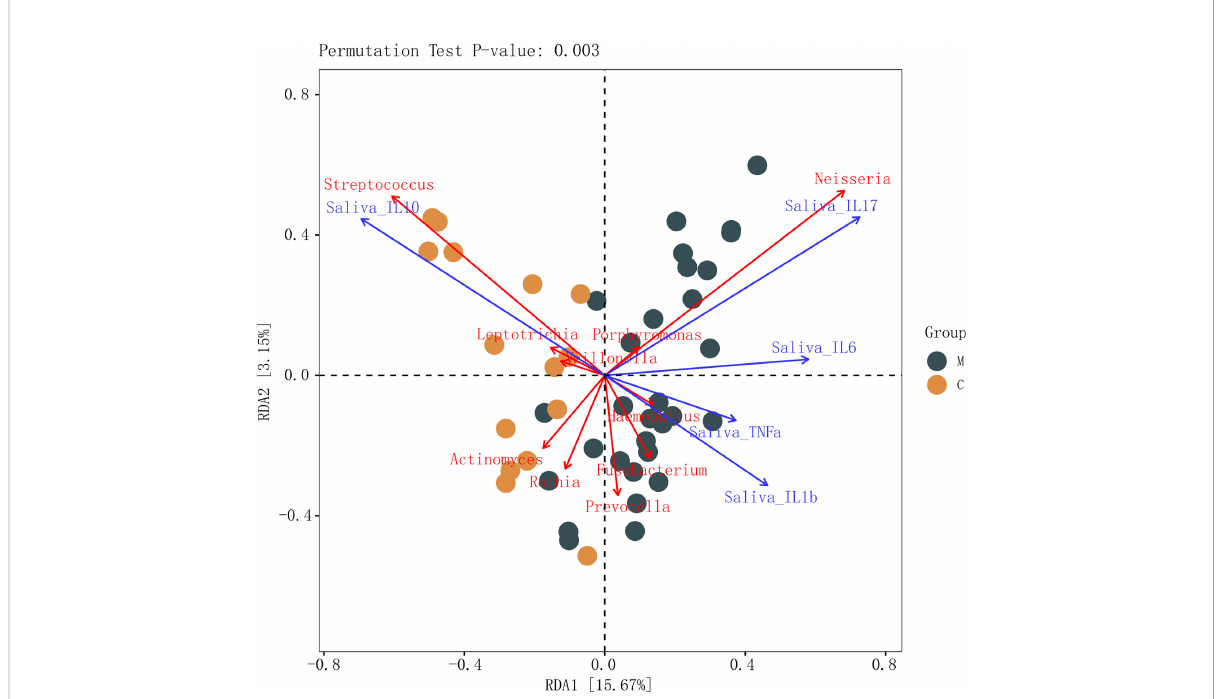
FIGURE 6 Connections between dental plaque microbiota and systemic immune in fl ammation. Redundancy analysis of in fl ammatory factors in the saliva and the top 10 genera in abundance in the methamphetamine using (M) and control (C) groups, permutation test P-value: 0.003. Each point represents a sample, different colored points belong to different groups. Blue arrows represent different in fl ammatory factors, red arrows represent bacterial genera, the angle between arrows represents the size of the correlation between